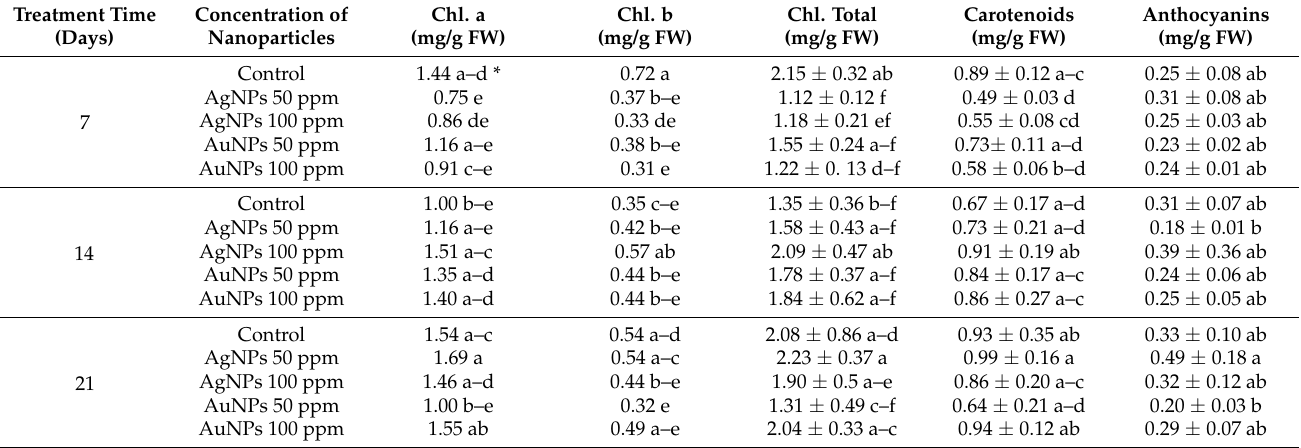
Table 3. Comparison of the influence of nanoparticles’ type and concentration on the photosynthetic pigments—chlorophyll (Chl.), carotenoids and anthocyanins content in rapeseed seedlings.